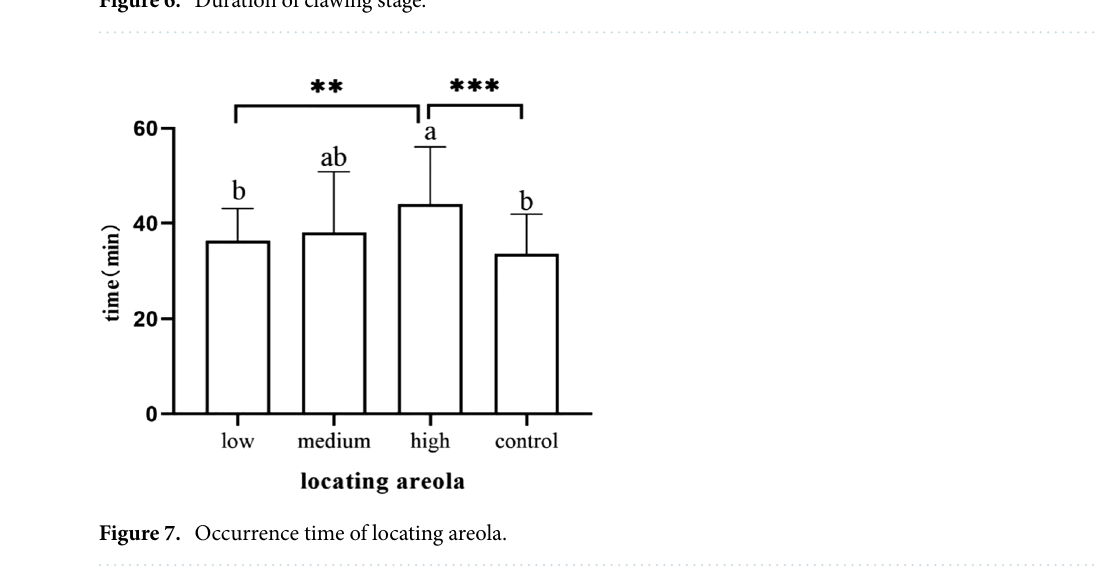
Figure 6. Duration of clawing stage.